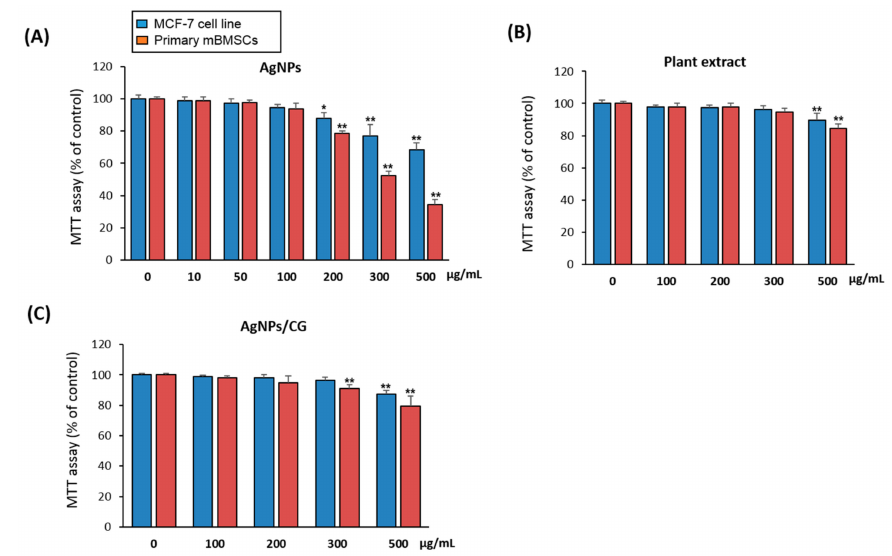
Figure 7. Cytotoxicity of AgNPs, plant extract and AgNPs / CG on animal cell culture. MCF-7 and mBMSCs cells were treated with di ff erent concentrations of ( A ) AgNPs, ( B ) plant extract, or ( C ) AgNPs / CG (50 µ g / mL + di ff erent concentrations of C. gigantean ) for 24 h, where cytotoxicity was measured using an MTT assay. Values are the mean ± SD (error bars) of three independent experiments (* p < 0.05, ** p < 0.005 compared to the control non-treated cell